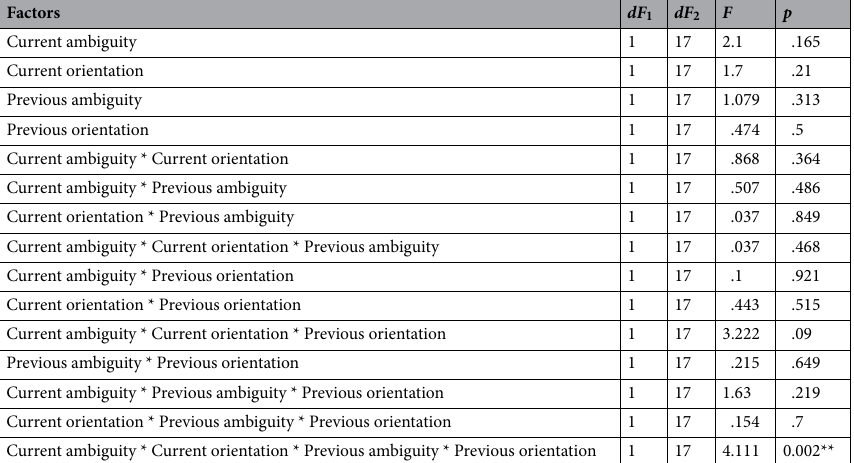
Table 3. Median presentation time of the current stimulus, PT [c] (ANOVA